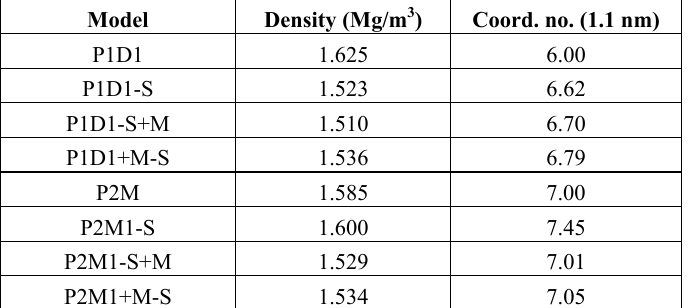
Table 1. Simulated densities and fullerene coordination numbers of the PCBM models, at 400